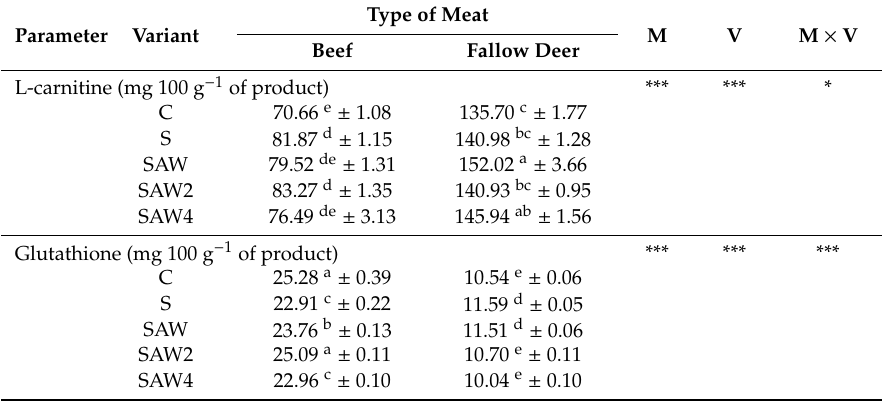
Table 5. Content of L-carnitine and glutathione in dry fermented sausages made from fallow deer and beef meat with di ff erent additives (mean ± standard